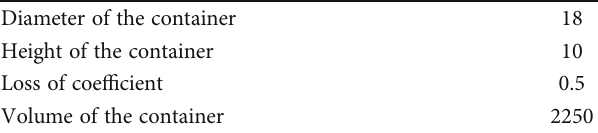
Table 4: Speci fi cation of storage